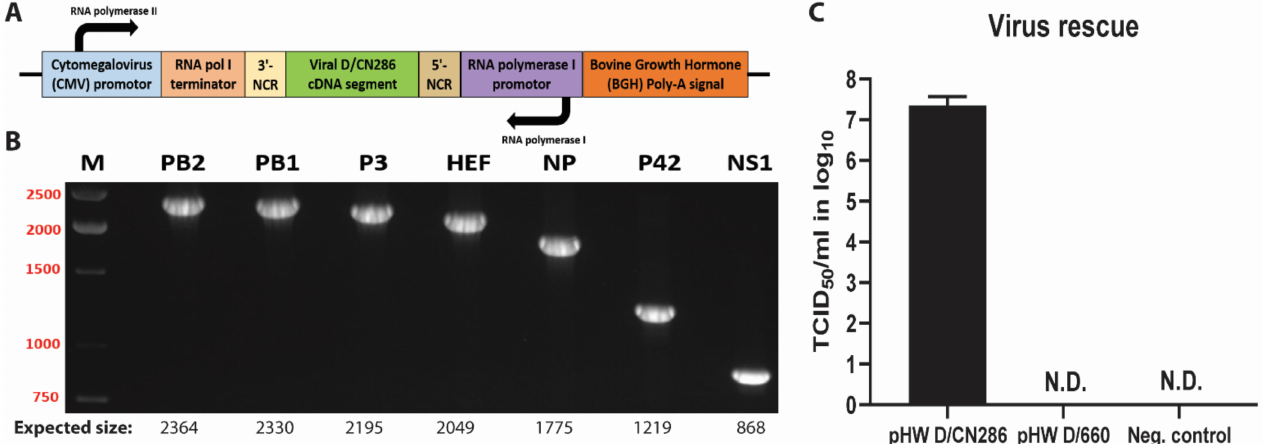
Figure 3. Establishment of a reverse genetic system for IDV. ( A ) A schematic representation of the genetic elements in the bidirectional pHW2000-backbone. ( B ) PCR confirmation of cloning the individual viral genomic segments into the pHW2000 plasmid using segment-specific primers. The PCR products were analysed by gel electrophoresis analysis on a 1% agarose gel. The expected fragment sizes are annotated under each lane for each viral genomic segment. ( C ) Viral titres of the reverse genetic clones D/CN286, D/660, and the negative control after a single passage on HRT-18G cells. Results are shown as means and SD of three individual experiments performed in two technical replicates per condition. Abbreviations: N.D.: not